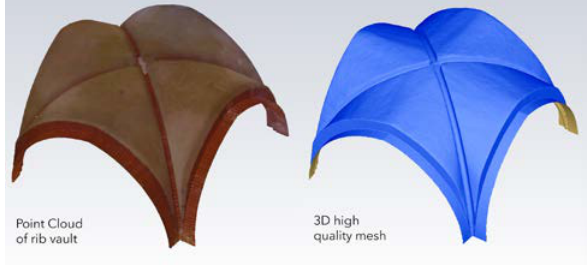
Figure 2. Reality-based model of rib vault.